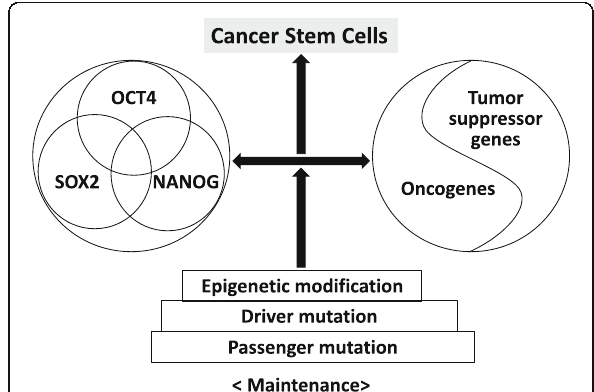
Fig. 1 Schematic representation of hypothetical two-hit theory for crosstalk to generate cancer stem cells by reprogramming. Hypothetical two-hit theory for induction of cancer stem cells was represented. Stemness factors (OCT4, SOX2, and NANOG) and oncogene/tumor suppressor genes (oncogenes such as Myc, KLF4, c-JUN, kRAS, etc.; antioncogenes such as p53, Rb, PTEN, BMI1, EZH2, INK4 family, etc.) and epigenetic modification of DNA methylation and histone modification are required for generation of cancer stem cells by reprogramming. We have reported the feedback control of c-JUN and OCT4 is critical for generation of cancer stem like cells [59]. The oncogene c-JUN transactivated genes encoding OCT4, SOX2, and NANOG [60], and the genes of OCT4, SOX2, and NANOG formed the molecular circuitry for stemness and pluripotency [64], and then OCT4 upregulated the expression of c-JUN gene to form the feedback circuit [59]. Taken together, we hypothesize that these feedback circuit might be regulated by the family of the stemness genes and the family